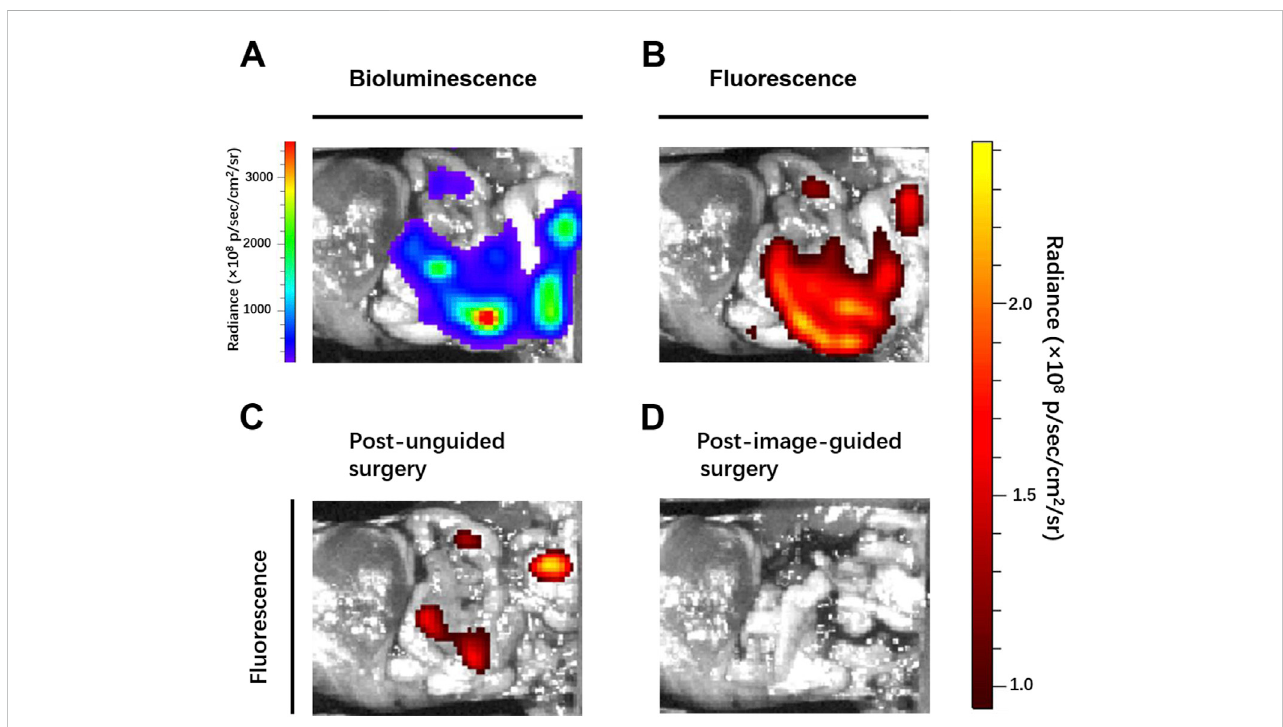
FIGURE 7 Mice with peritoneal metastases wereintravenously injected with 200 μ L of ADPH NPs (30 μ M based on ADHP) and operated on 24 h after injection: (A) bioluminescence and (B) fl uorescence images of the peritoneal cavity of mice before tumor resection. Fluorescent images typical of mice (C) post unguided surgery and (D) post second surgery with guidance of the fl uorescence of ADHP